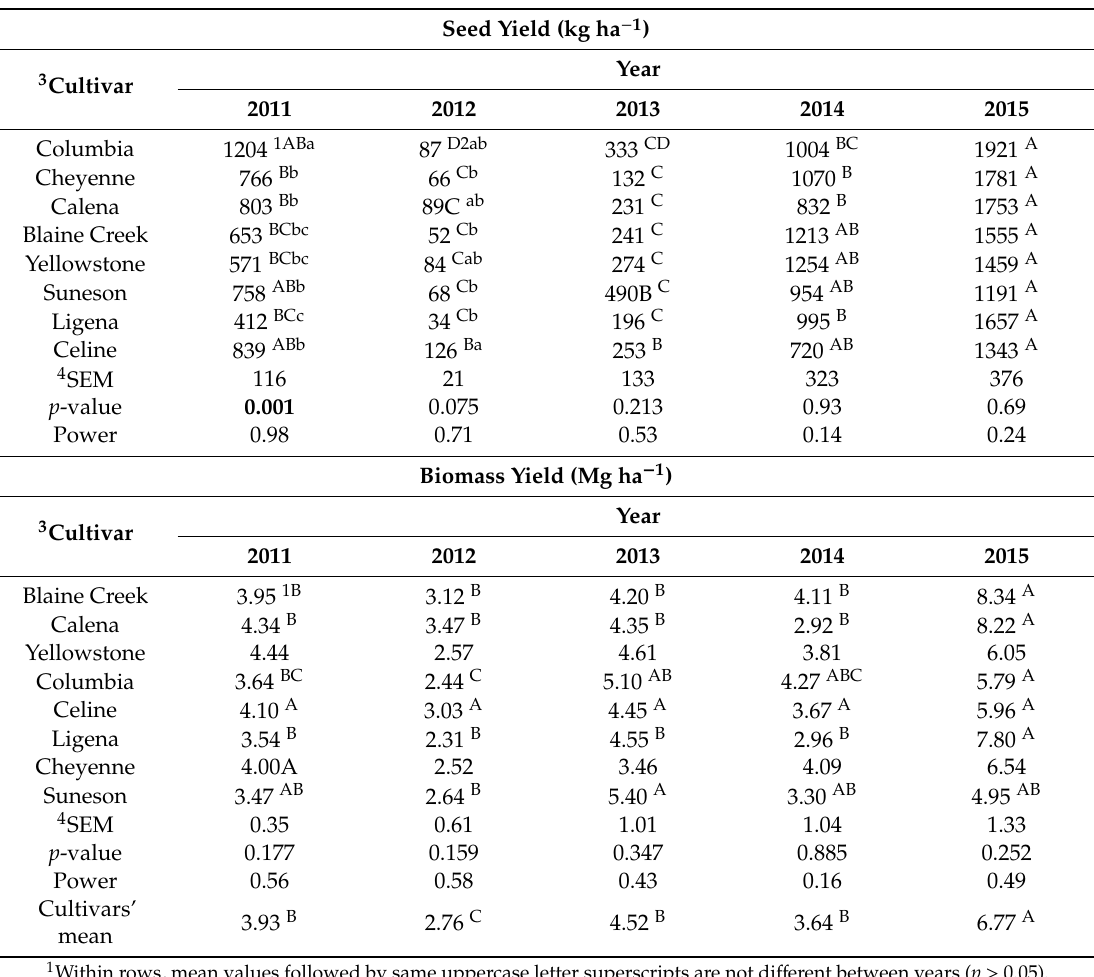
Table 5. Interaction e ff ect of cultivar × year on seed yield (kg ha − 1 ) and biomass yield (Mg ha − 1 ) of the eight C. sativa cultivars grown during the spring growing season of 2011 to 2015 in Reno, Nevada,